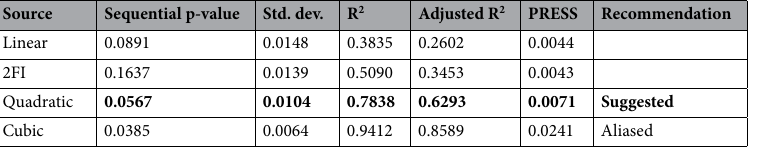
Table 10. Model summary statistics of high peaks zone for hot-rolled steel. Significant values are in bold.